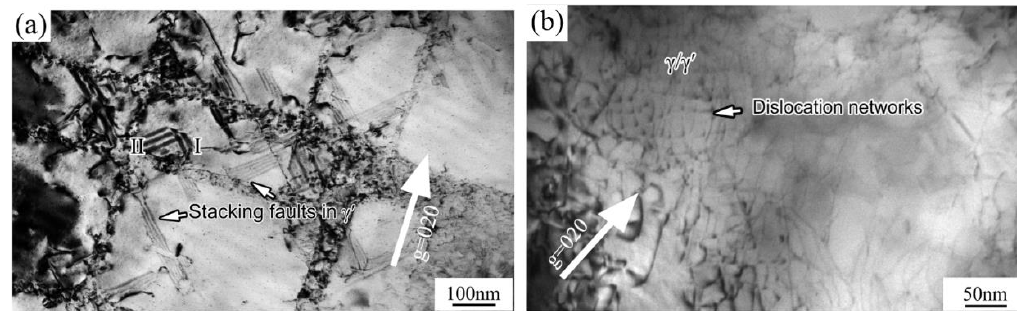
Figure 5. TEM images of deformation microstructures at intermediate temperatures: ( a ) 760 °C; ( b ) 900 °C.